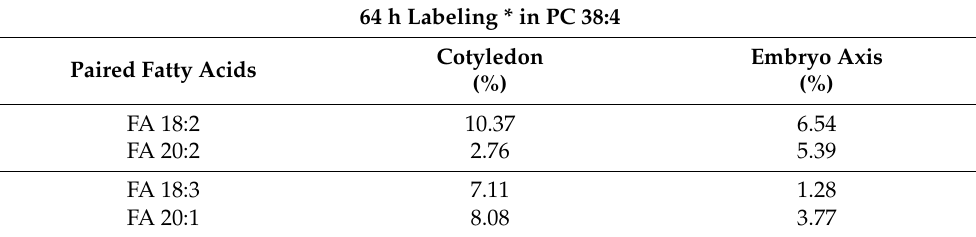
Table 1. Average labeling in fatty acids within PC 38:4 from